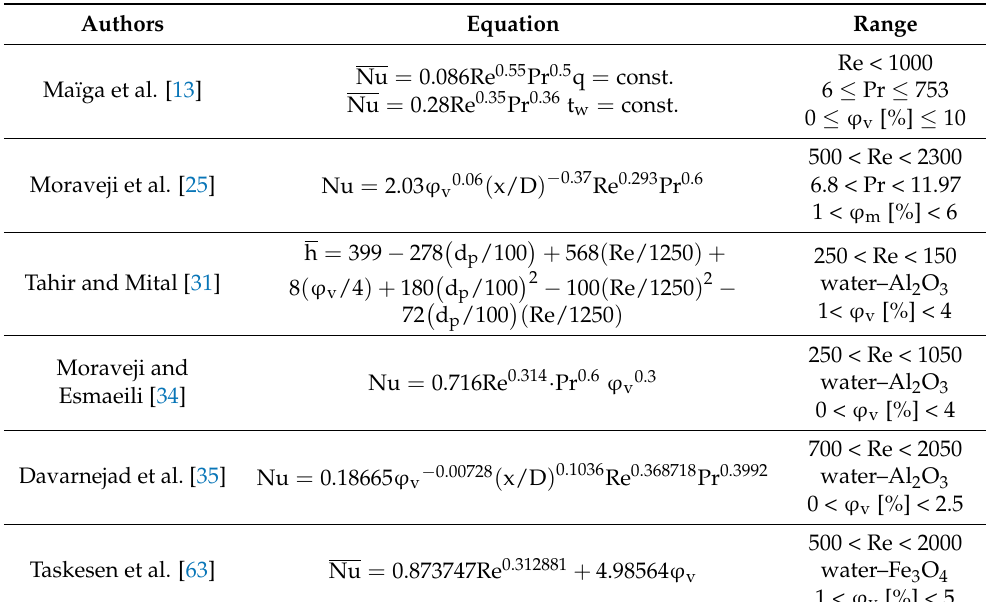
Table 3. Correlation equations for laminar flow of